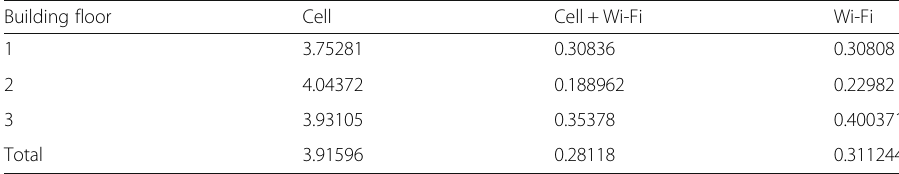
Table 4 The mean distance error of location determination in the second-fold cross